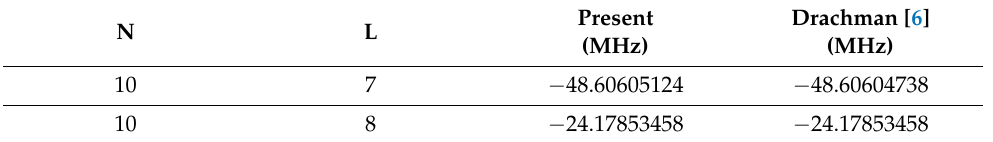
Table 4. Comparison of the presently calculated Rydberg states with the results of Drachman. N L